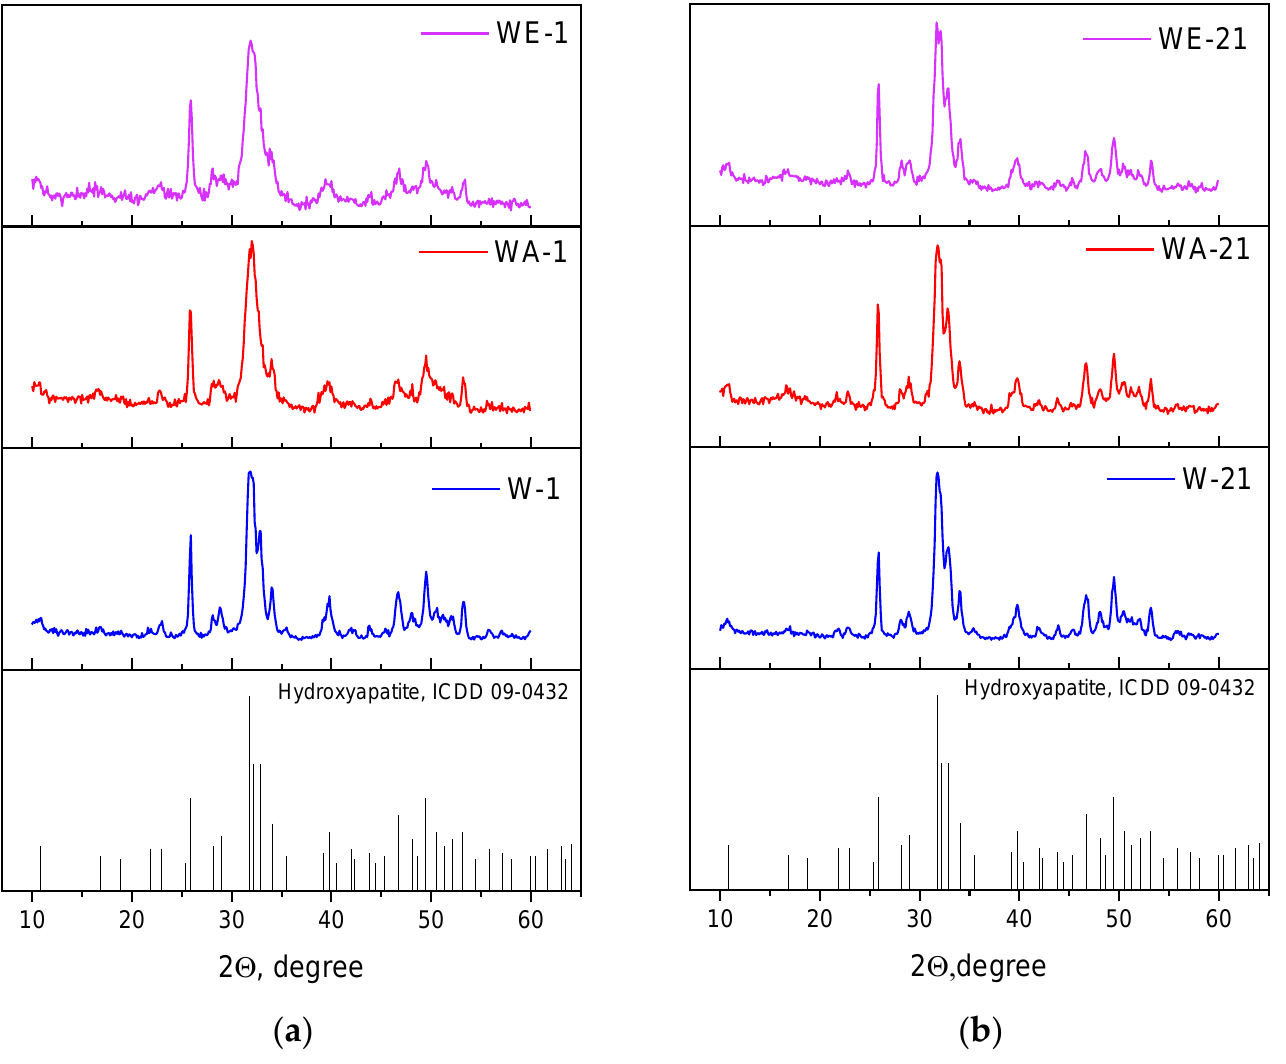
Figure 1. XRD data of the as-synthesized powders ( a ), and those data after 21 days of ripening ( b ). Table 2. Characteristics of the lattice parameters and crystallite sizes of the